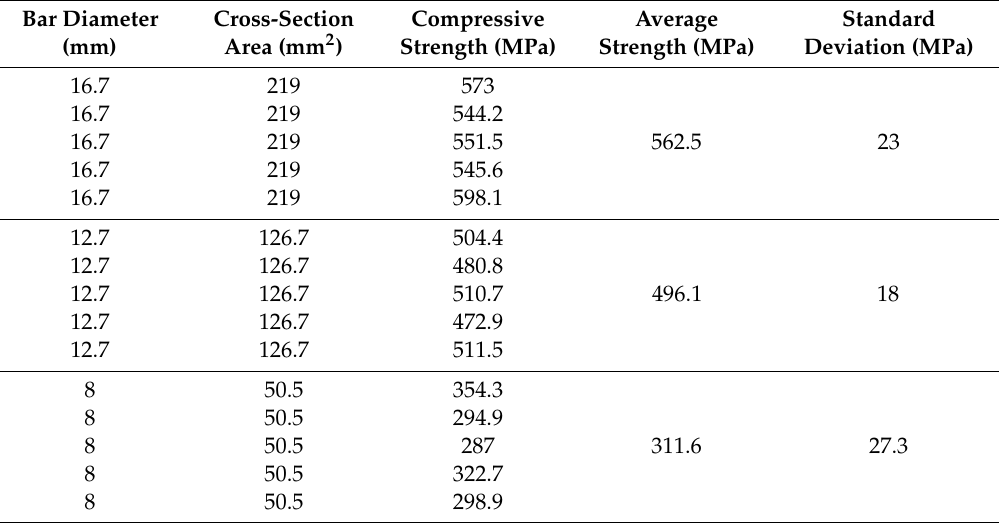
Table 2. Properties of the GFRP reinforcements .